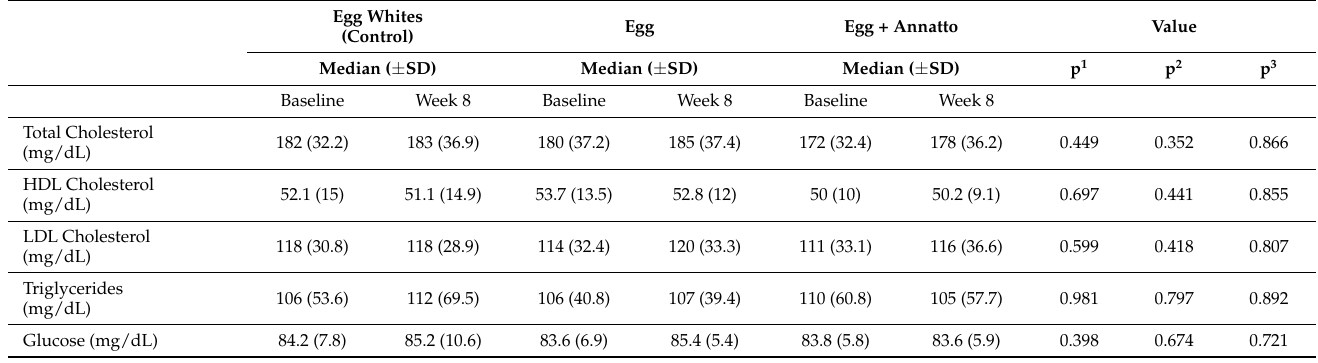
Table 2. Effects on traditional cardiovascular risk markers in the study population according to the